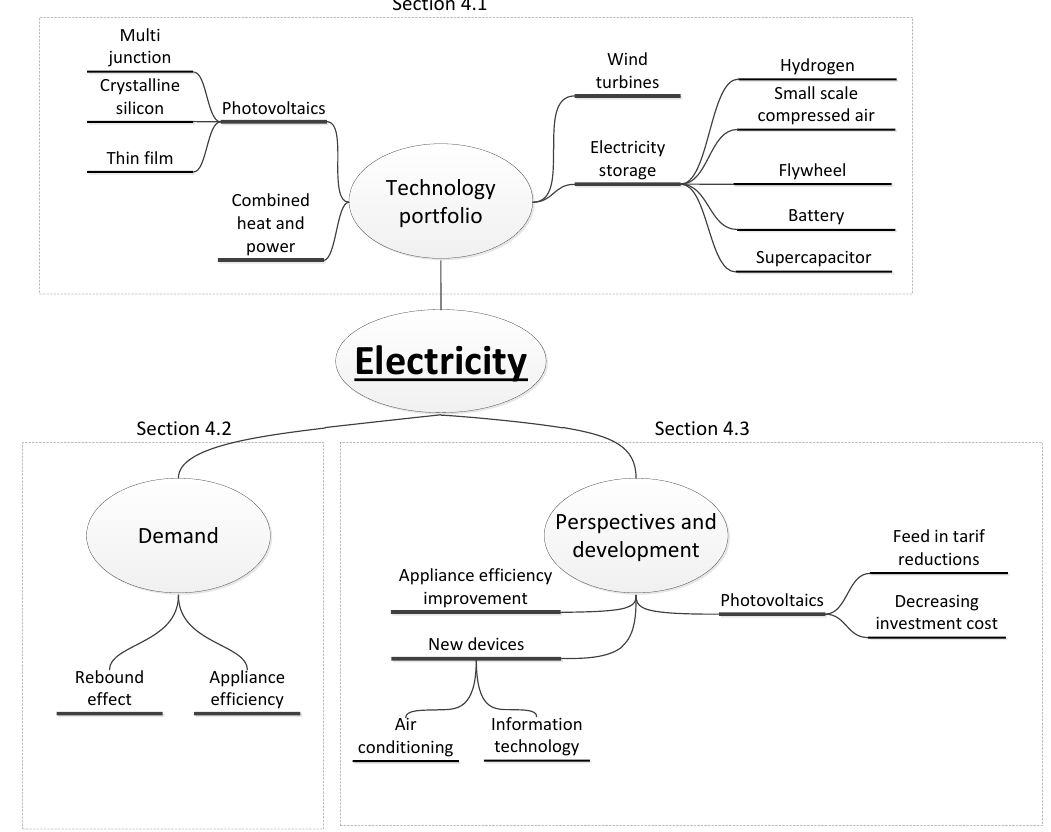
Figure 4. Overview of the electricity section and the respective subsections. Section 4.1 deals with the technology portfolio, Section 4.2 electricity discusses demand dependencies, and Section 4.3 describes perspectives and developments. The branches indicate considered aspects within a subsection.